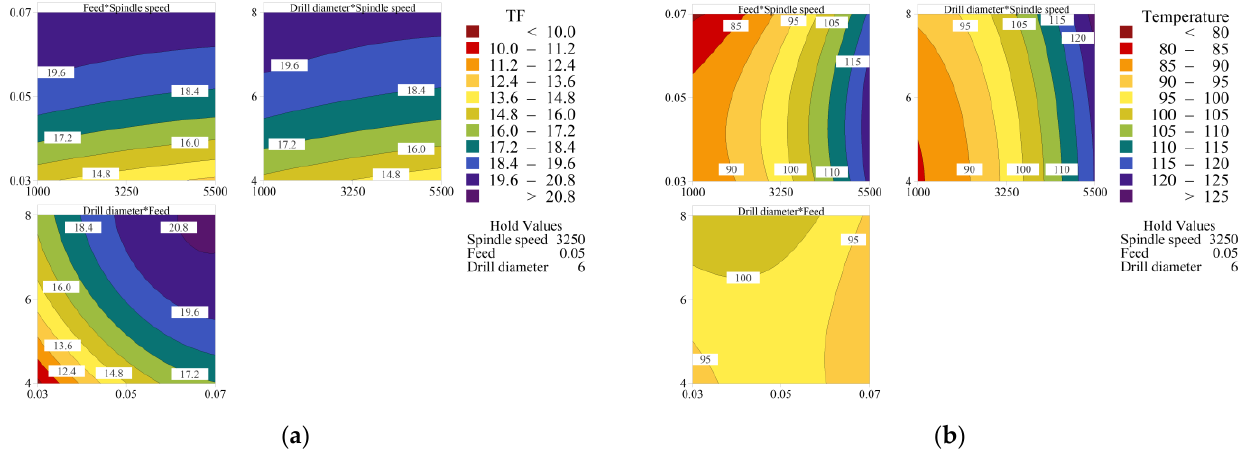
Figure 13. Contour plot of neat CEC ( a ) thrust force and ( b ) temperature.